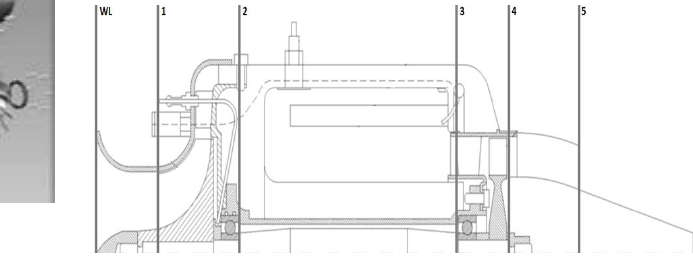
Fig. 2. Diagram of the jet engine with marked stations